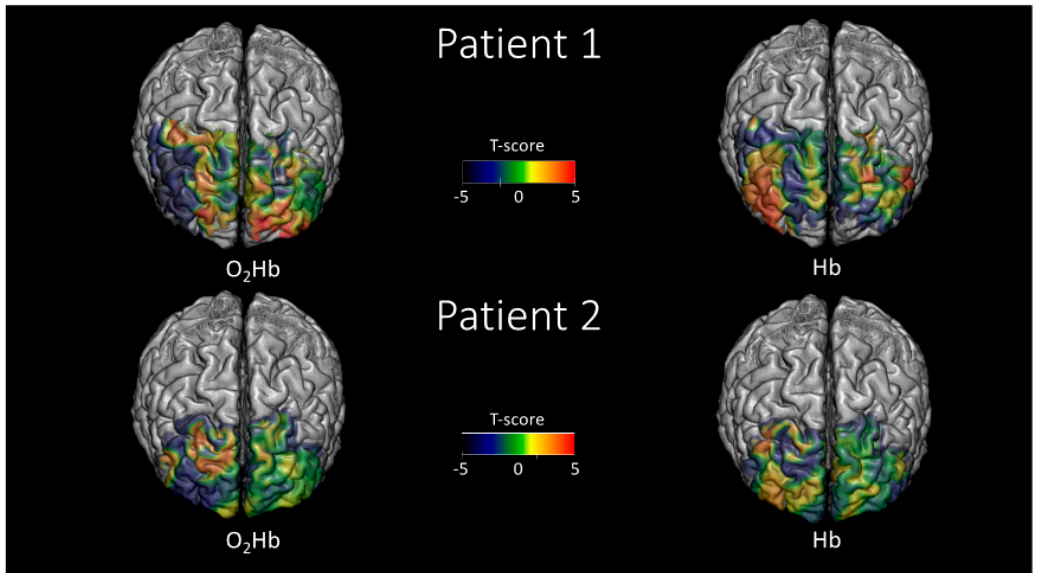
Figure 5. Statistical parametric maps (t-scores) evaluated employing the functional near-infrared spectroscopy-diffuse optical tomography (fNIRS-DOT) analysis and the General Linear Model (GLM) approach during the Silent Word Generation (SWG). The maps are reported in regions where the spatial sensitivity of the optical array was su ffi cient (up to an attenuation of the average optical sensitivity of 1000